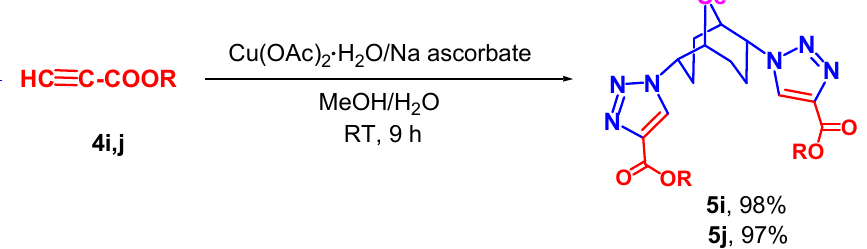
Scheme 6. Synthesis of compound 5i , j by the 1,3-dipolar cycloaddition reaction of diazido derivative 3 with methyl and ethyl propiolates 4i , j .